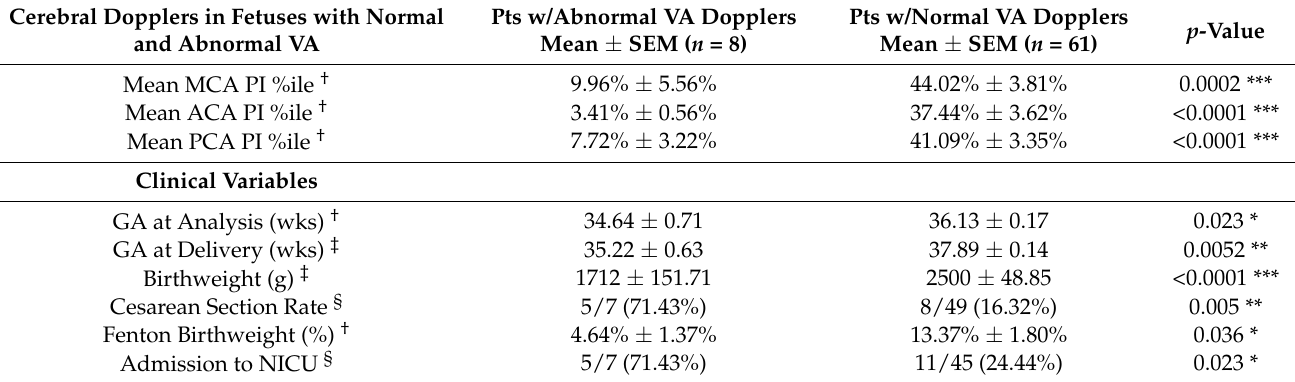
Table 4. Comparison of patient characteristics in fetuses with and without abnormal VA Doppler (<5th